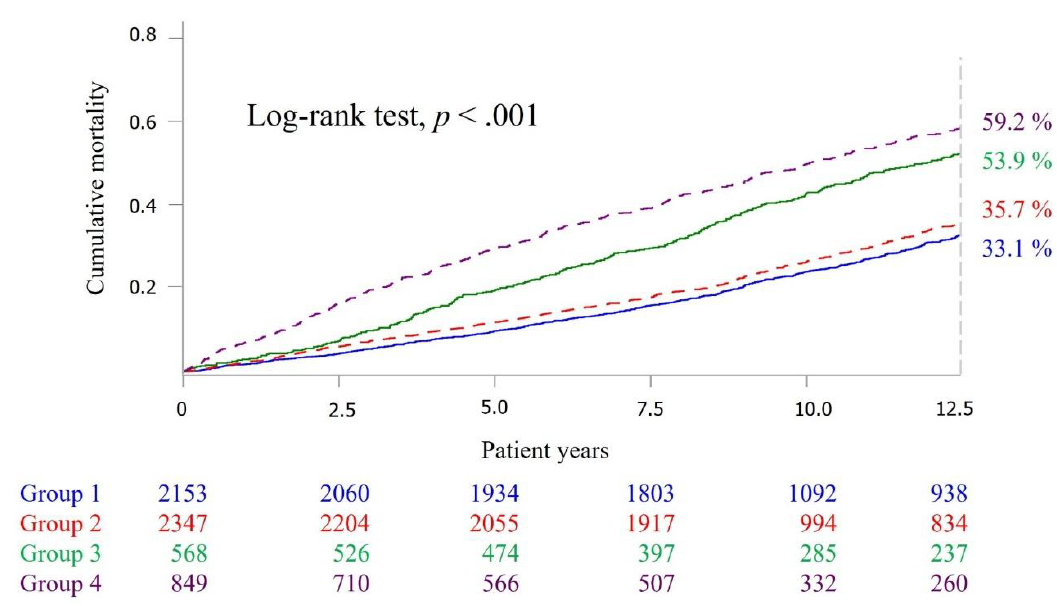
Figure 3. Kaplan–Meier survival curves among groups. Group 1: nonwidowed with social participation; Group 2: non-widowed without social participation; Group 3: widowed with social participation; Group 4: widowed without social participation.